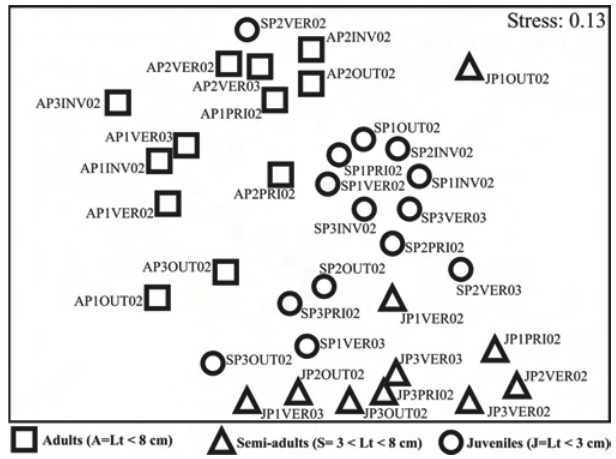
Fig. 4. MDS on the different sizes, sites and seasonal indepen- dent groups. The total length (Lt) categories compared were Juveniles (J = Lt < 3 cm), Semi-adults (S = 3 < Lt < 8 cm) and Adults (A = Lt > 8 cm) . The three sites sampled along the catch- ment were: site 1 (P1), an upstream first order section of the basin near its spring; site 2 (P2), a second order middle section of the basin; and site 3 (P3), a downstream third order section of the basin. Seasons compared were: VER=summer (December, Janu- ary and February), OUT=Autumn (March, April and May), INV=Winter (June, July and August) and Spring=PRI (Septem-